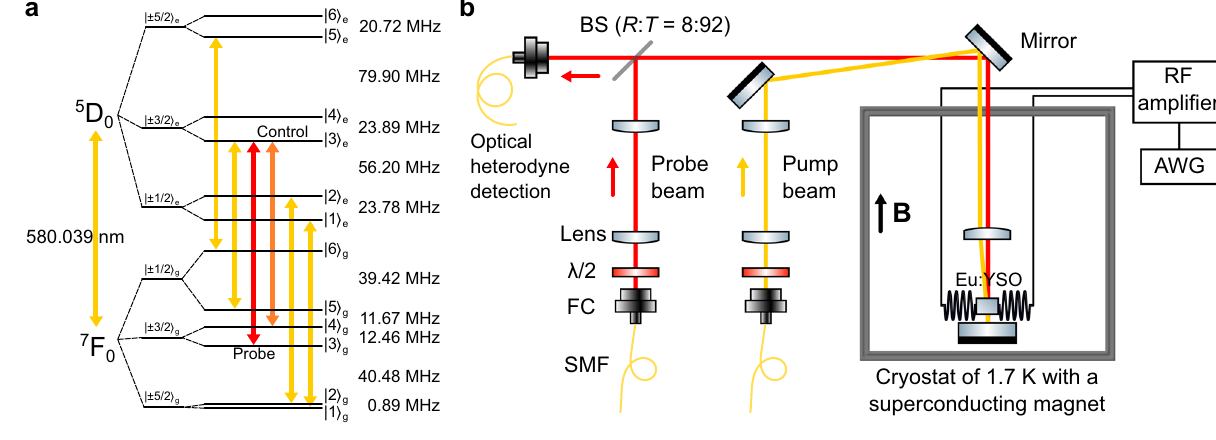
Fig. 1 Energy level diagram and experimental setup. a The laser at 580.039nm is resonant with electronic state 5 D 0 and 7 F 0 of 151 Eu 3 + :Y 2 SiO 5 , which split into six hyper fi ne levels respectively in the ZEFOZ magnetic fi eld. 3 j i , 4 j i , and 3 j i form the Λ system for the long-lived spin-wave AFC storage. g g e Details about the hyper fi ne structure and the pumping scheme can be found in the Supplementary Note 2. The AFC is prepared in the 3 j i g level. The control pulse resonant with the 4 j i and 3 j i transfers the optical coherence into a spin wave and drives the spin wave back to the optical regime. b g e Schematic of the experimental setup. The probe and pump beam are emitted with single-mode fi bers (SMF) and fi ber collimators (FC) before entering the cryostat. The two beams are arranged in a non-collinear con fi guration. Half-wave plates ( λ /2) control the polarization of the beams, and two pairs of lenses are used to obtain proper beam widths at the position of the crystal. A BS (beam splitter) with a re fl ection-to-transmission ratio of 8:92 is employed to ef fi ciently collect the transmitted signal. The probe beam is re fl ected by the mirror at the bottom of the cryostat and coupled to a SMF for optical heterodyne detection after passing through the BS. A pair of coils placed at the two sides of the sample is driven by an arbitrary waveform generator (AWG) with the output ampli fi ed with a 300-W RF ampli fi er.